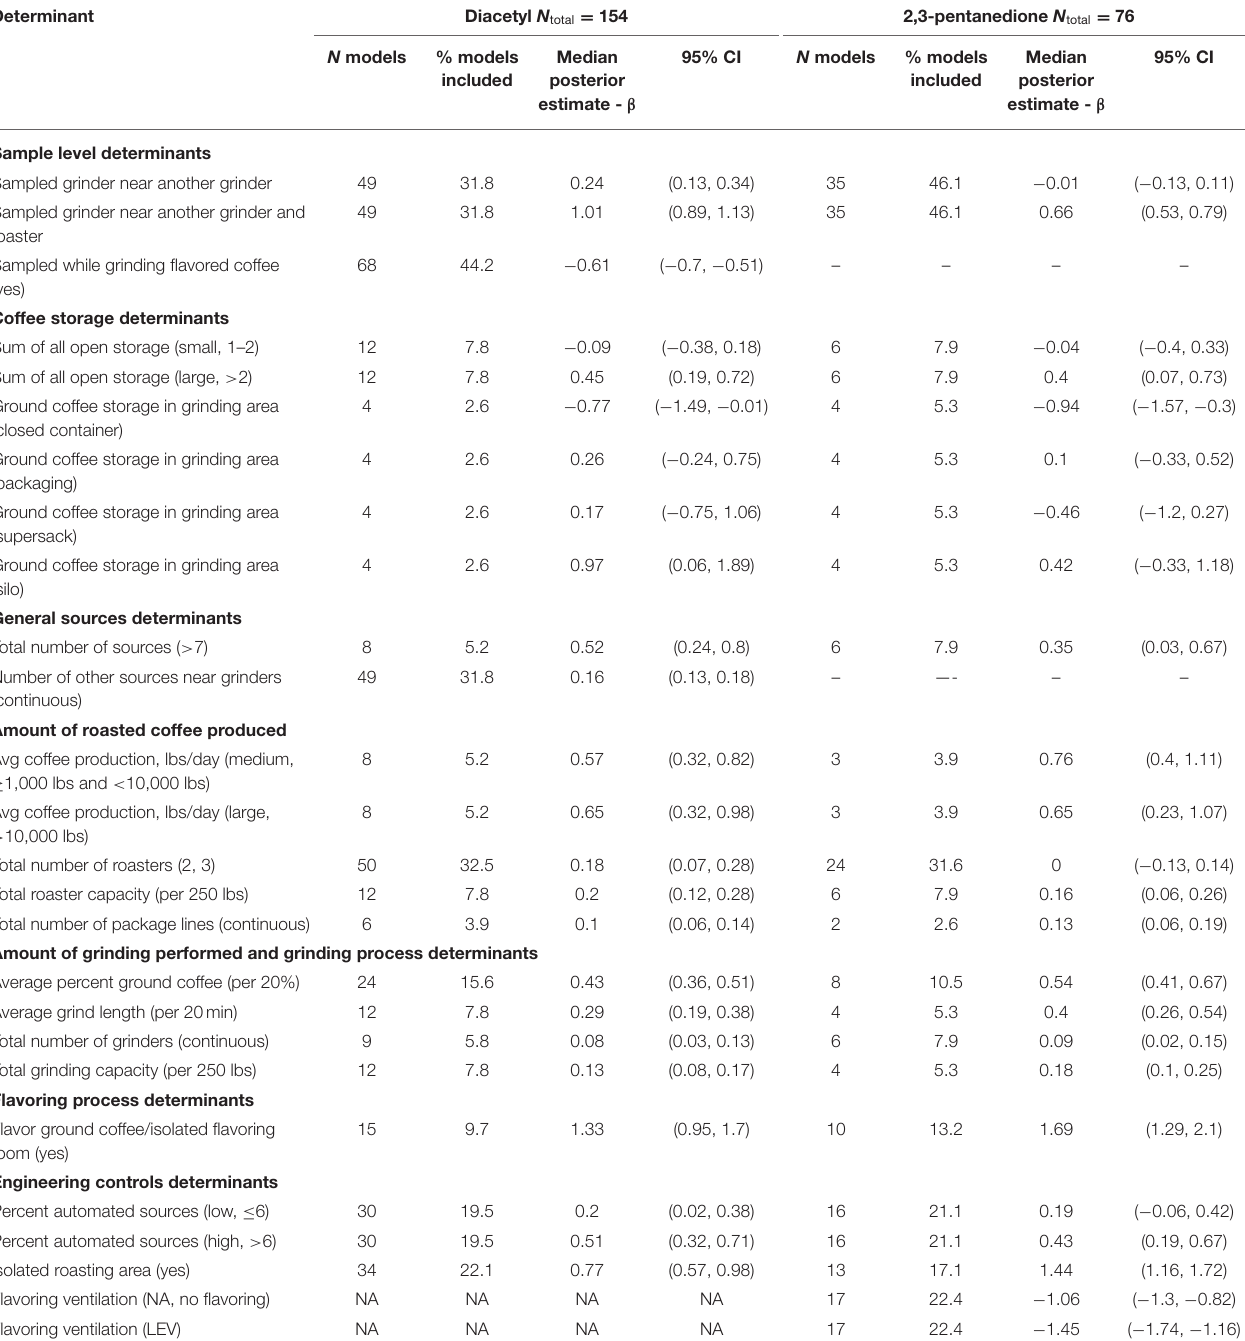
TABLE 4 | Bayesian model averaging results for diacetyl and 2,3-pentanedione exposures during grinding tasks.